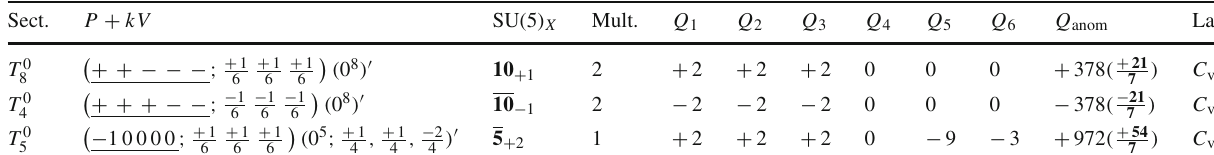
Fig. 2 A high dimensional term. The fractional numbers in the brackets are Q anom / 126